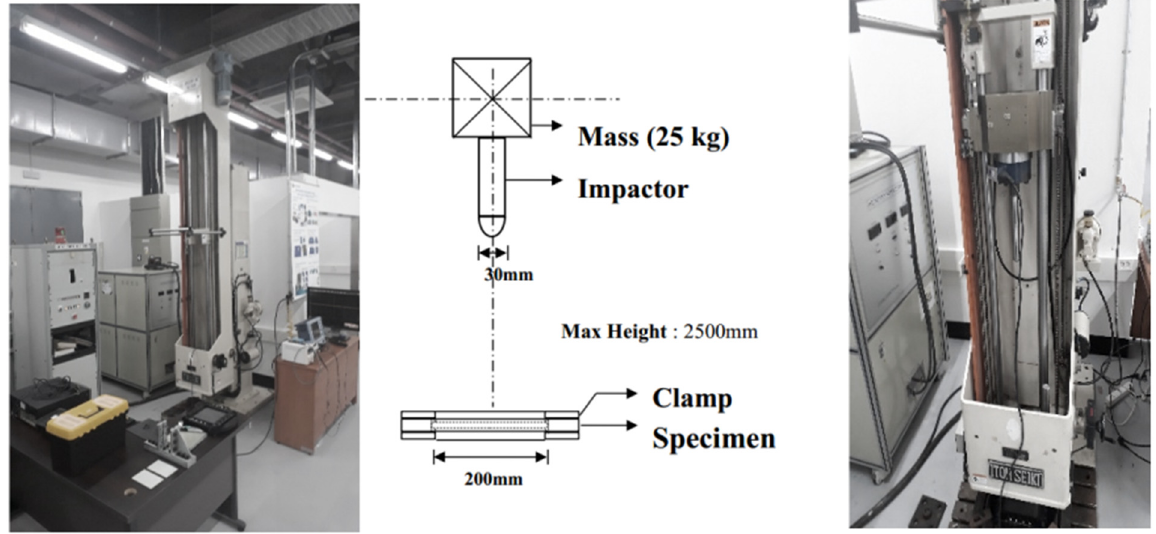
Figure 3. Impact drop tester machine specification (ITOH SEIKI Co. Ltd., Chonburi, Thailand).